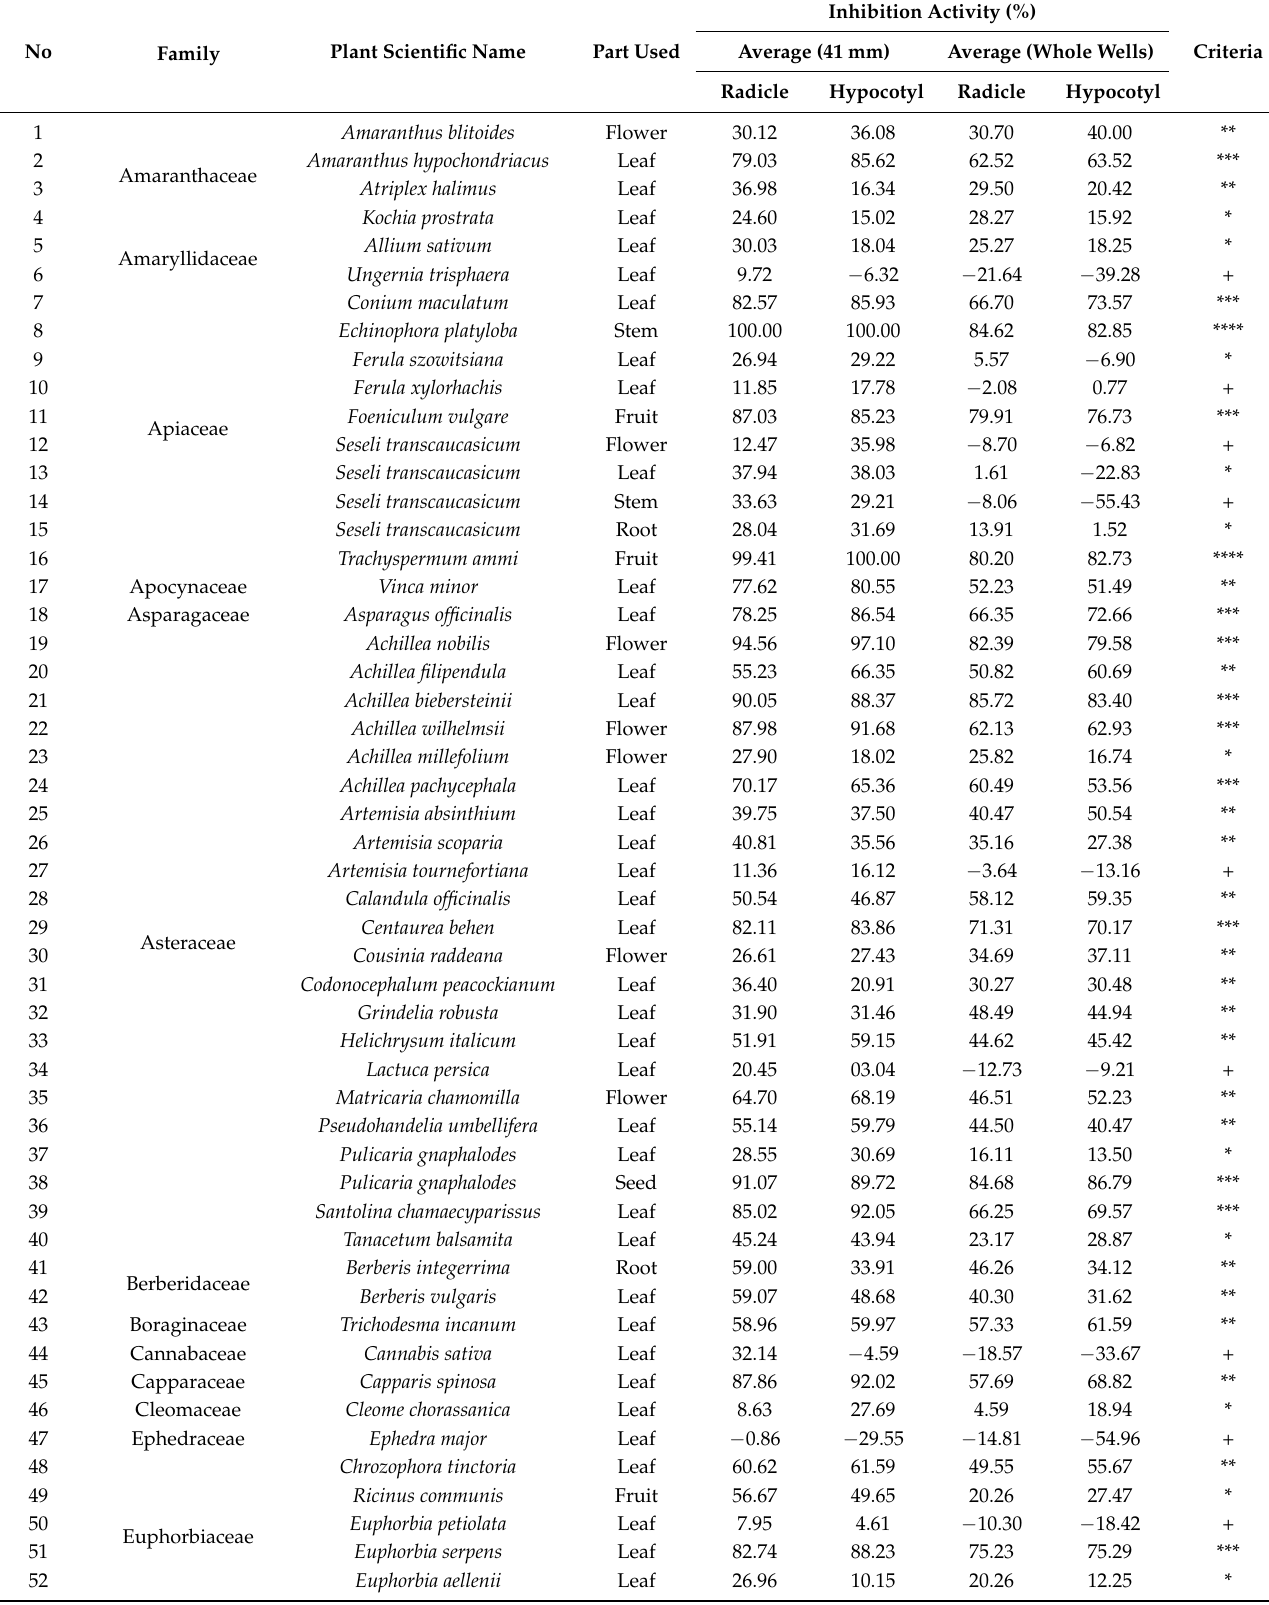
Table 1. The results of investigating the inhibitory power of medicinal plants on the growth of lettuce